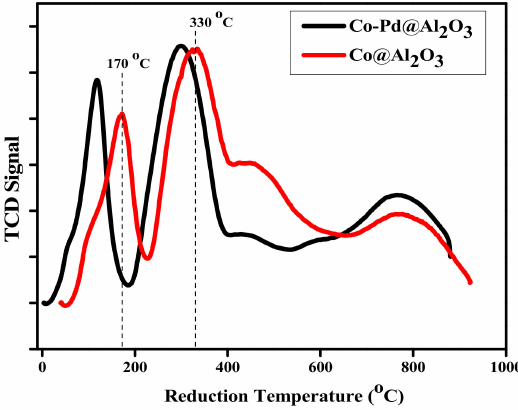
Figure 4. TPR profile of the prepared catalysts.